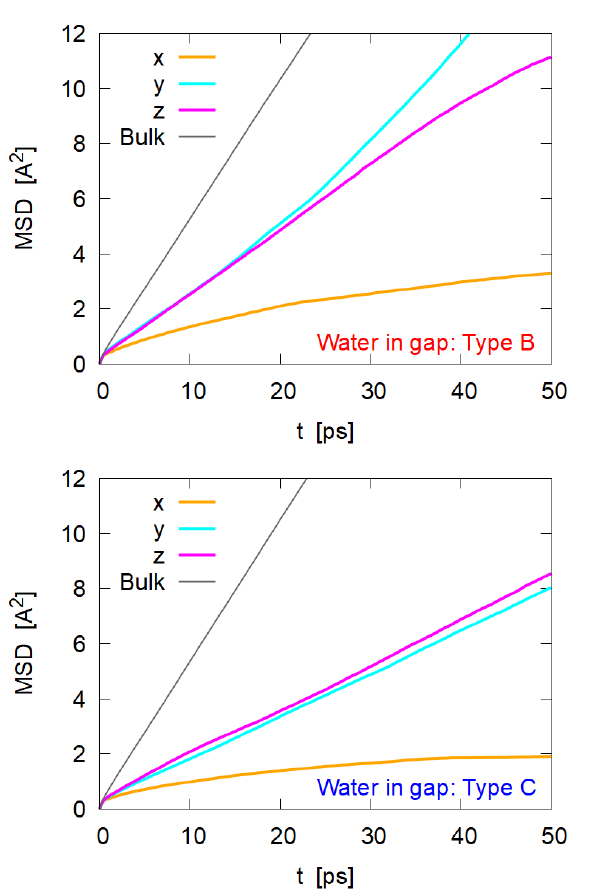
Figure 8. Mean square displacement (MSD) of water molecules in the gap region between the adsorbed cellulose nanocrystal and the oil phase. “Bulk” indicates the MSD of water molecules far from both the cellulose and the water–oil